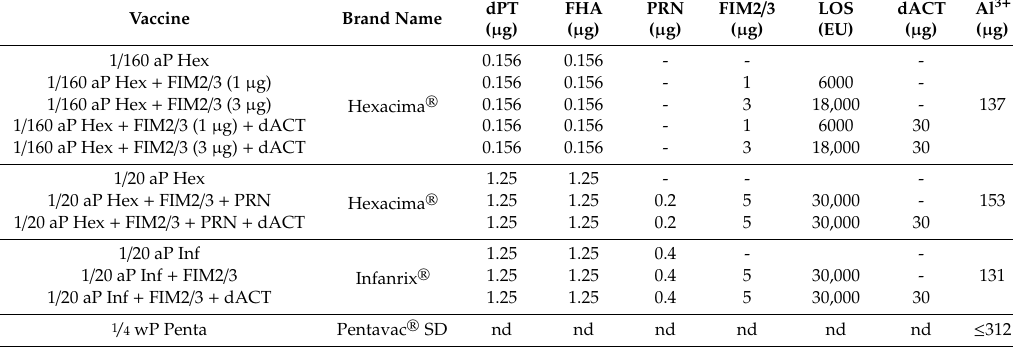
Table 1. Composition of the used